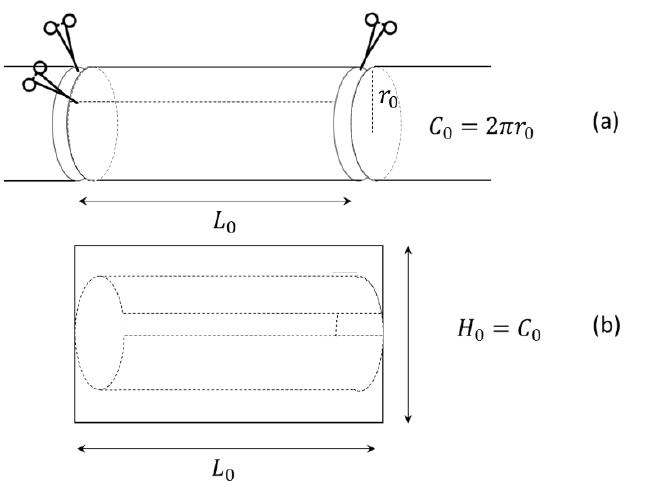
Figure 2. LILT procedure. ( a ) Removal of an intestine part of length 𝐿 𝑜 . ( b ) Developed